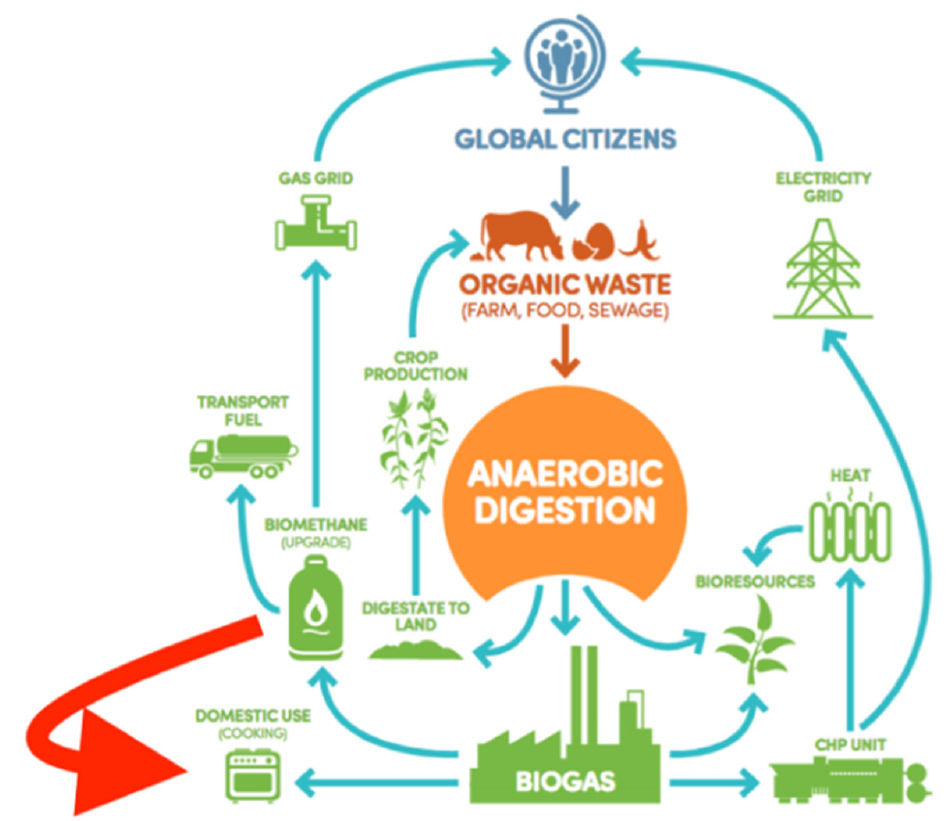
Figure 1. Anaerobic digestion systems and the proposed opportunity for compressed and bottled biogas (modified from [3]).